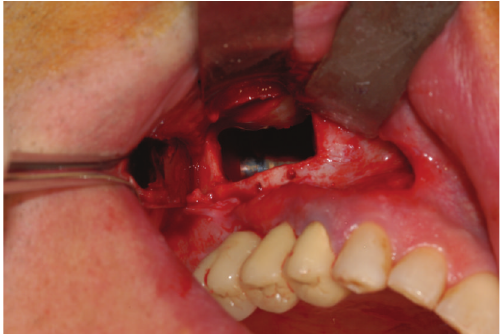
Figure 6: The implant is perfectly visible lying on the sinus floor.